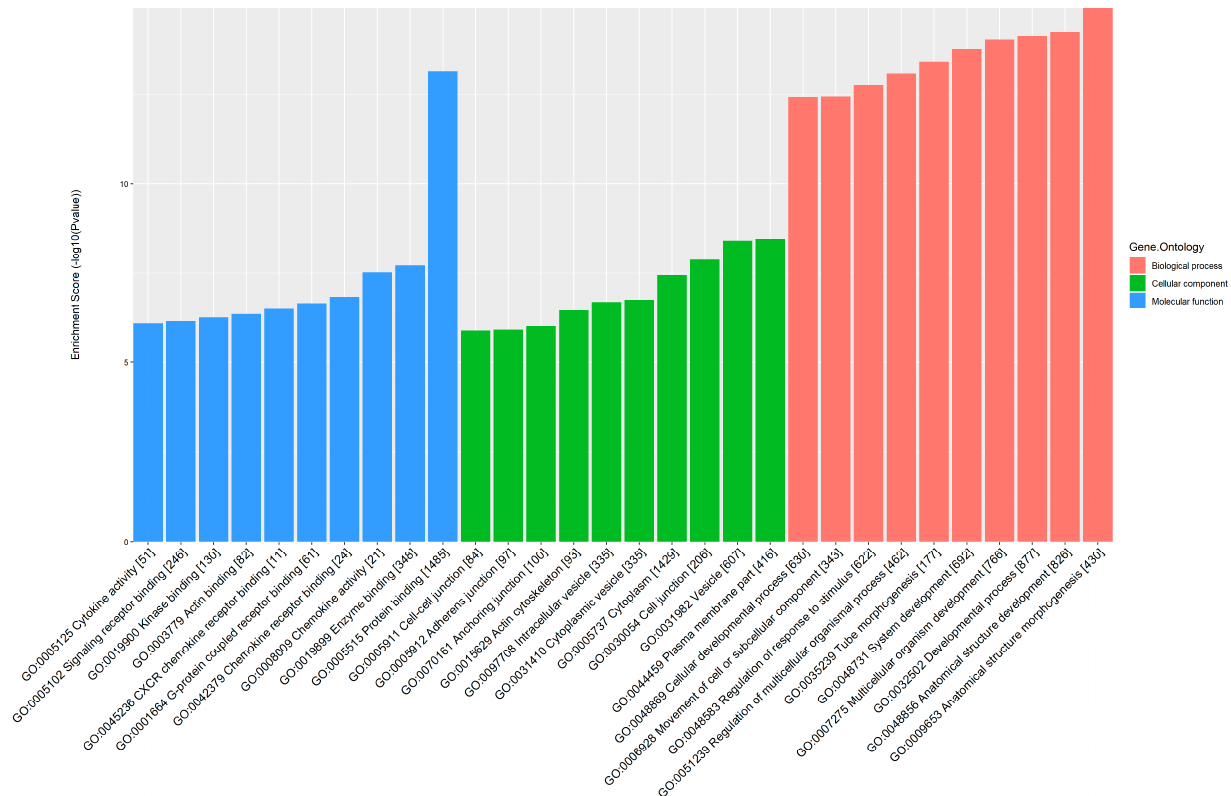
Figure 5. Gene ontology (GO) analysis of di ff erential m6A-modi fi ed mRNAs.